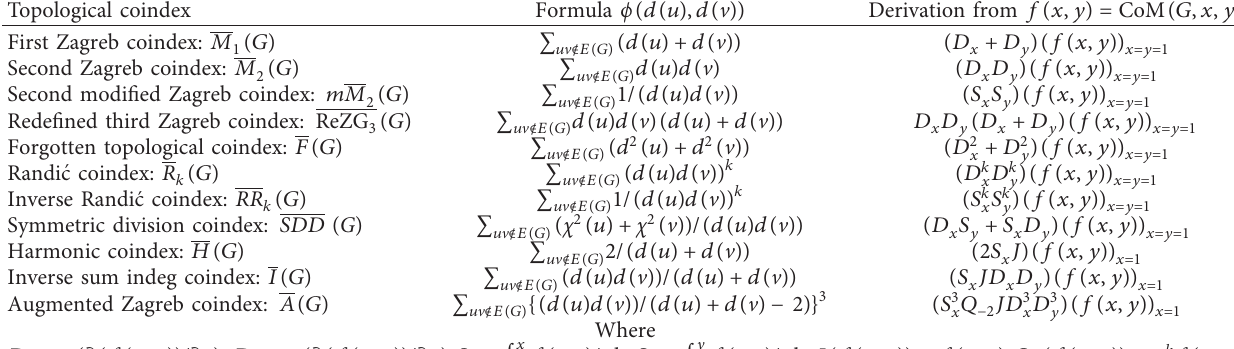
Table 1: Topological coindices and its derivation from CoM-polynomial.